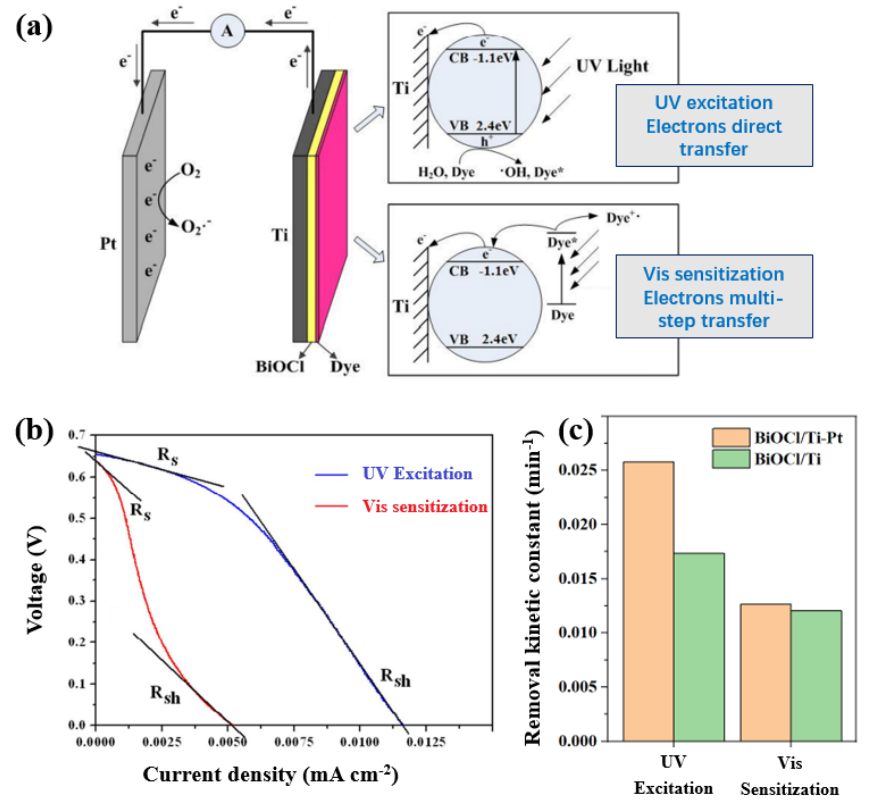
Figure 8. ( a ) Schematic diagram of BiOCl/Ti − Pt dye-sensitized PFC and the corresponding electron transfer path, ( b ) series resistance (R s ) and parallel resistance (R sh ) calculated under UV and visible light irradiation, and ( c ) RhB removal kinetic constant obtained in BiOCl/Ti system and BiOCl/Ti-Pt PFC system under UV and visible light irradiation. Reprinted/adapted with permission from Ref. [89]. 2013, American Chemical Society.